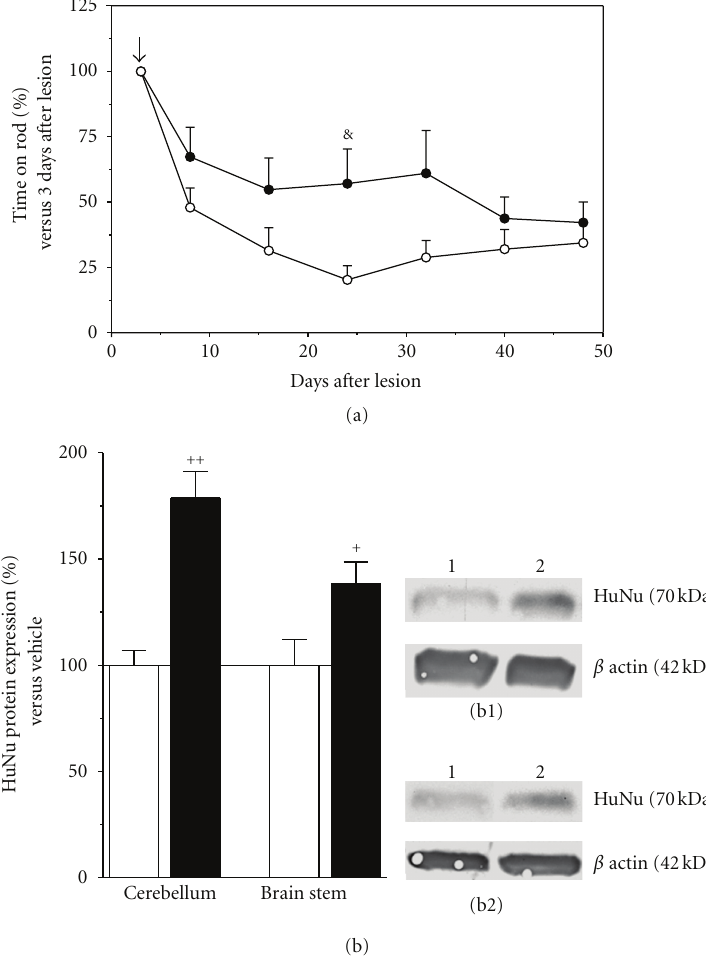
Figure 1: HuUCBMCs grafts improve motor coordination and reach the cerebellum and brain stem of 3-AP ataxic rats. Motor performance, as assessed by the rotarod test, shows a progressive impairment in 3-AP-lesioned rats receiving vehicle ((a) white circles) that reaches a plateau between 15 and 24 days after lesion. Motor coordination in 3-AP-lesioned rats that received HuUCBMCs grafts ((a) black circles) is significantly improved at 24 days after lesion. Time of implantation of HuUCBMCs ( ↓ ). (b) shows the detection by western blot of HuNu protein in the cerebellum and brain stem of 3-AP-lesioned rats treated with vehicle (white bars), or with HuUCBMCs (black bars). (b1) and (b2) show representative blots for HuNu protein in the cerebellum (b1) and brain stem (b2). Lane 1: 3-AP-lesioned rats treated with vehicle (3-AP + vehicle); lane 2: 3-AP-lesioned rats treated with HuUCBMCs grafts (3-AP + cells). Results represent the mean ± SEM of 4 (b) to 10 (a) individual animals. & P ≤ 0 . 05 versus 3-AP + vehicle rats at 24 days after lesion, + P ≤ 0 . 05, ++ P ≤ 0 . 01 versus 3-AP + vehicle rats at 48 days after